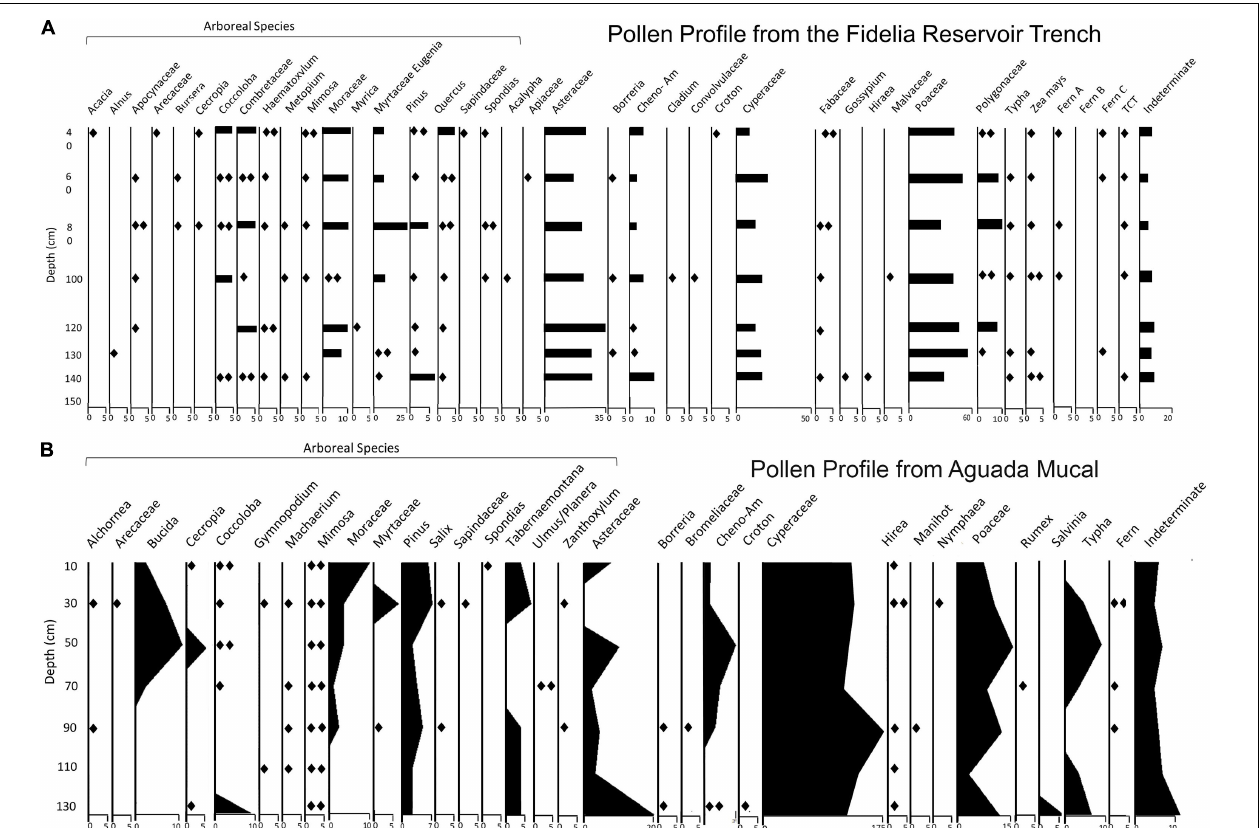
FIGURE 4 | Pollen profiles taken from Operations 19A (A) and 25Z (B) . Note that in pollen profile (A) , calibrated radiocarbon dates of 360–170 BCE and 993–1155 CE were associated with the sediment from depths of 150 cm and 80 cm BS, respectively. In profile (B) , organic matter from 130 cm BS produced an AMS date of 160 BCE–40 CE, and 90 cm BS produced an AMS date of 1160–1270 CE.